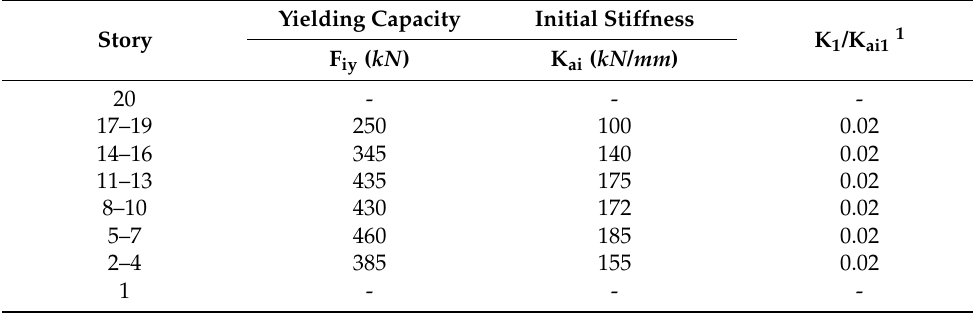
Table 2 . Technical parameters of design BRBs. Table 2. Technical parameters of design BRBs.